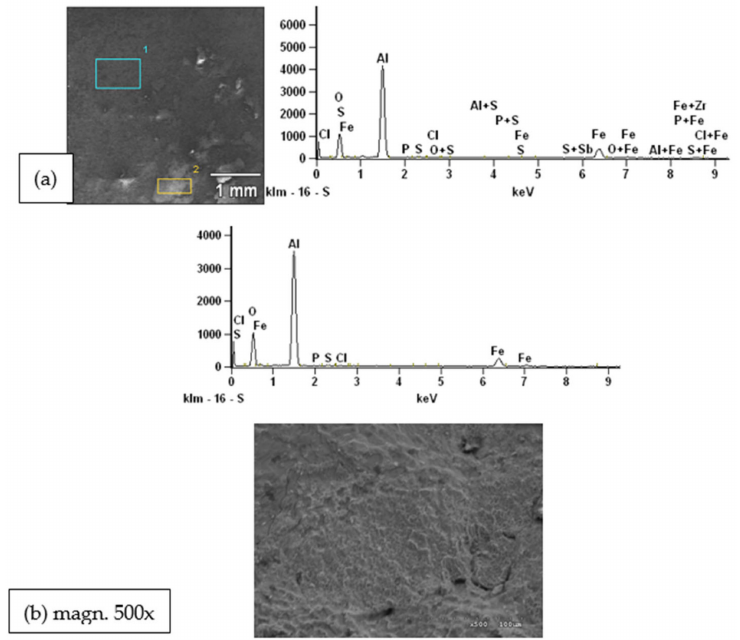
Figure 20. ( a ) Chemical composition of the FeAl intermetal surface in the pt1 and pt2 surfaces; ( b ) microscopic photo (SEM) of the FeAl intermetal